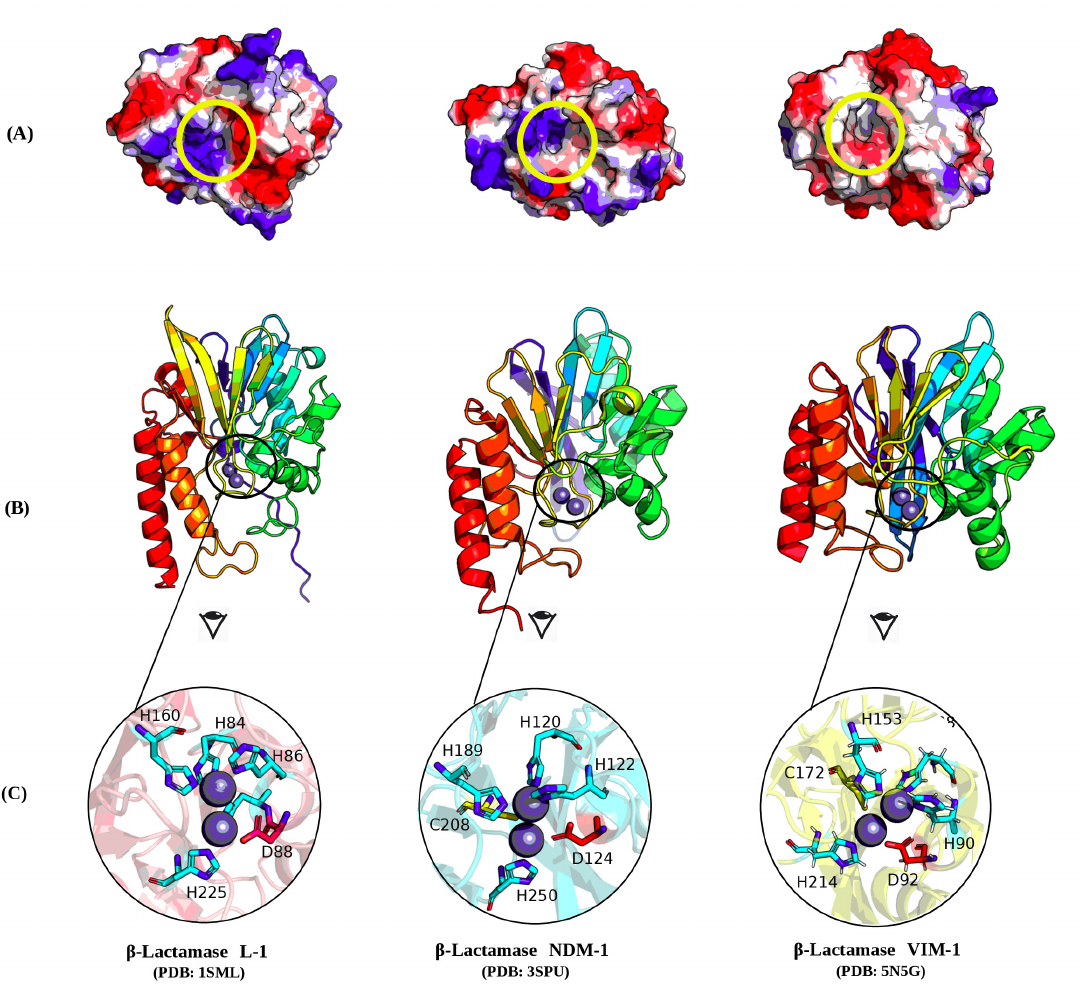
Figure 6. Three-dimensional (3D) structural representation of NDM1, L1, and VIM1 metallo- β -lactamases sharing the same catalytic sites. The crystal structures of NDM1, L1, and VIM1 were extracted from the Protein Data Bank (PDB) using codes 3SPE, 1SML, and 5N5G, respectively. ( A ) Electrostatic potentials are presented on the surface of enzymes using the molecular graphics system PyMOL, with the yellow circle showing a similar conserved cavity forming the catalytic site. ( B ) Enzyme structures with the same orientation are presented in cartoon mode. Similar structural components (sheets and helices) with conserved shapes are highlighted, and rainbow colors code for different structures, highlighting enzyme compartment similarities. ( C ) Catalytic sites for the three enzymes are also highlighted in yellow sticks to show the similarity of these functional regions.